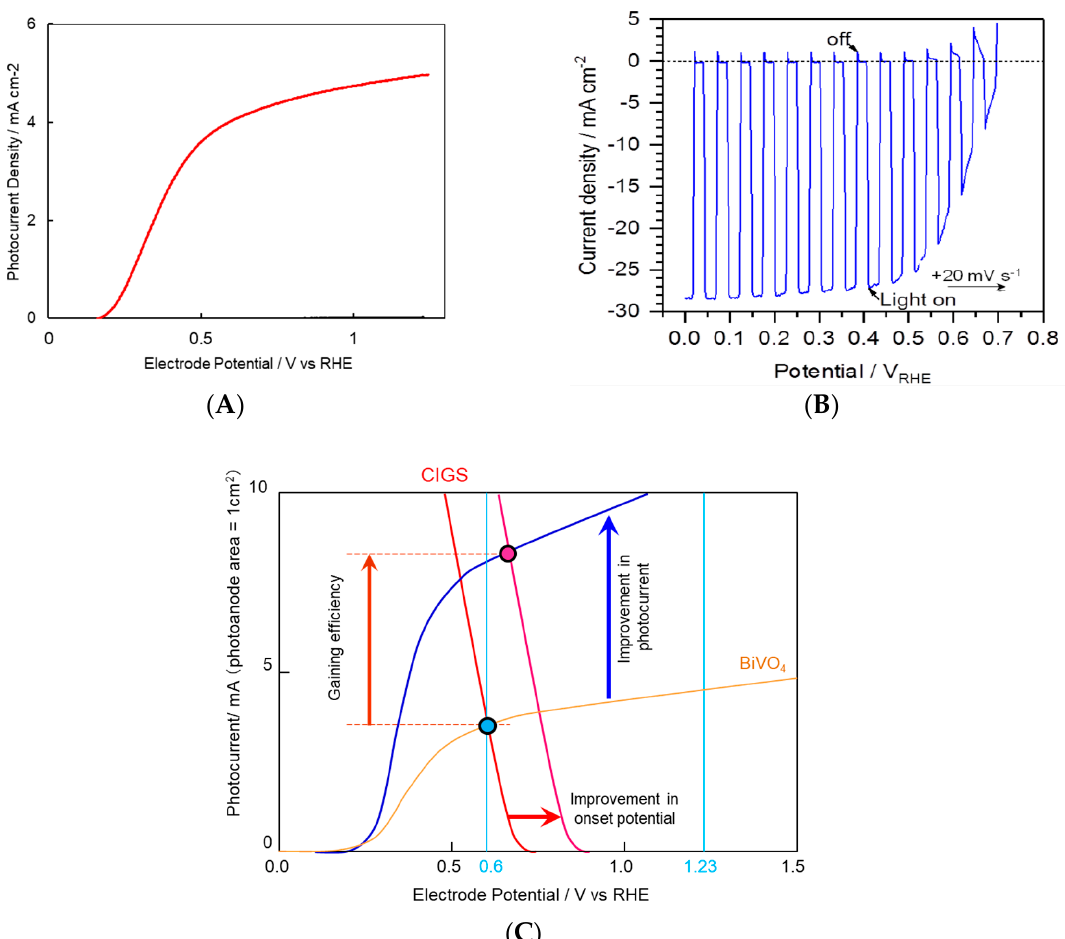
Figure 4. Examples of photoelectrochemical curves (current density-versus-potential curves in linear-sweep voltammetry) for ( A ) an O 2 -evolving semi-transparent NiFeO x /BiVO 4 /ITO photoanode (reproduced from [6], in 1 M potassium borate (pH 9.3) solution containing 0.2 M Na 2 SO 3 with (red curve) or without (black curve, “dark current”) AM 1.5 G solar simulator irradiation at room temperature, with a sweep rate of 10 mV · s − 1 ), ( B ) a H 2 -evolving Pt/CdS/CuIn 0.44 Ga 0.56 Se 2 /Mo/soda lime glass photoanode (our dedicated experiment in a pH 9.8 phosphate buffer with chopped AM 1.5 G solar simulator, showing the dark current and lighted current on one curve, swept at 20 mV · s − 1 ). ( C ) shows a schematic viewgraph for the stand-alone dual photoelectrode operation for overall water photo-splitting. The curves of a real BiVO 4 semi-transparent photoanode (blue curve) and a CIGS photocathode (red curve) (The sign of photocurrent is inverted.) under AM 1.5 G solar simulator irradiation are reproduced. The light acceptation areas were 1 cm 2 for both. The cross point of these curves corresponds to the steady-state operational photocurrent evolving 2H 2 and O 2